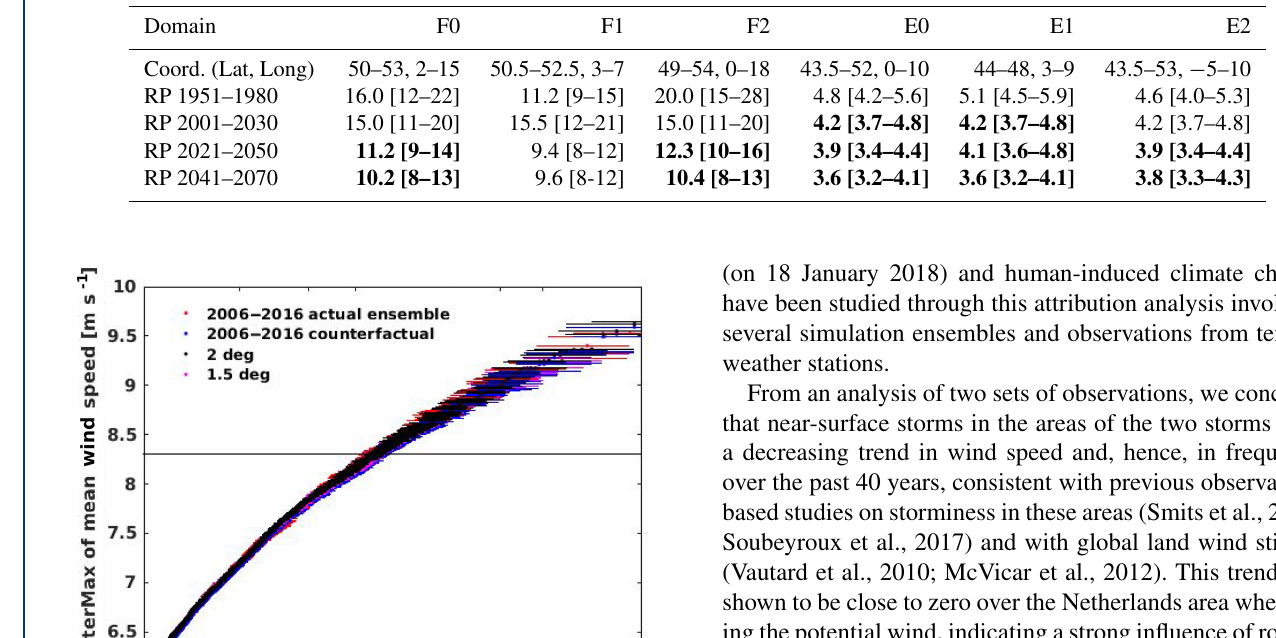
Table 4. Sensitivity experiment results. Return periods and their confidence intervals (in square brackets) for the different time periods and the RACMO simulations. Each column contains results for one domain experiment. Return periods are all given for return value characteristics of the storms (15 years for Friederike and 4.2 years for Eleanor); F0 is storm Friederike, domain as in Table 2; F1 is the same with a smaller domain focused more on the Netherlands; F2 is larger domain including parts of UK; E0 is storm Eleanor, as in Table 3; E1 is the smaller domain; E2 is the larger domain. The coordinates (Lat, Long) of domains are indicated in the first data row. Bold numbers are significantly different from the value in 1951–1980.